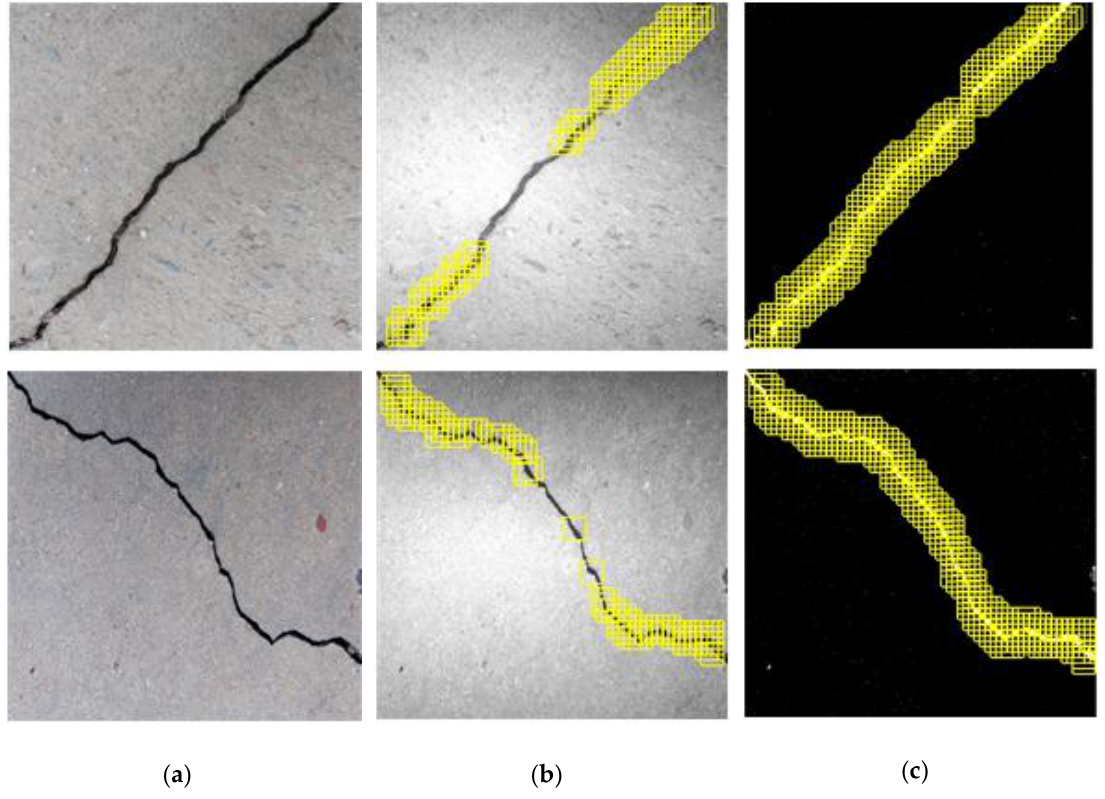
Figure 21. The ( a ) original crack images, and the results of crack position detection (CPD) based on ( b ) the original CPD and ( c ) the MLP–CNN, under the influence of light spots.